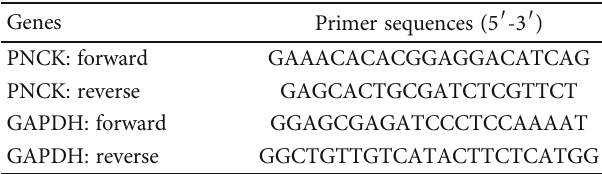
Table 1: The primer sequences included in this study.